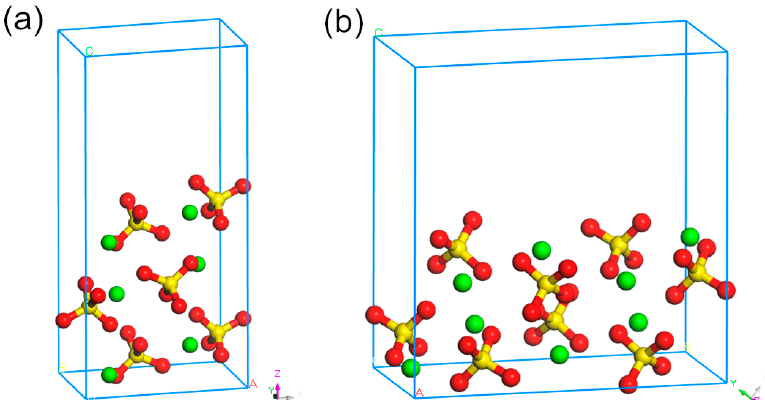
Figure 4. ( a ) {001} cleavage surface and ( b ) {210} cleavage surface of celestite (built in the Visualizer of Materials Studio Program 8.0). Green atoms are Sr atoms, yellow atoms are S atoms, and red atoms are O atoms.